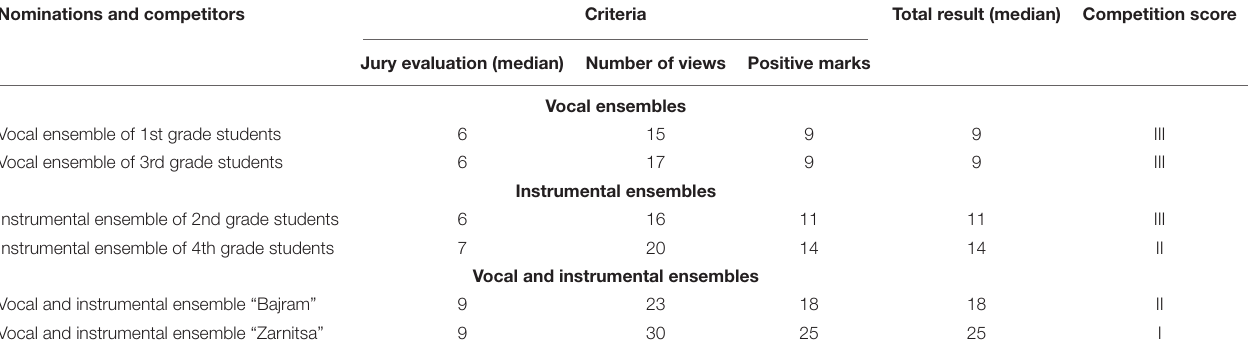
TABLE 5 | Competition results. Nominations and competitors